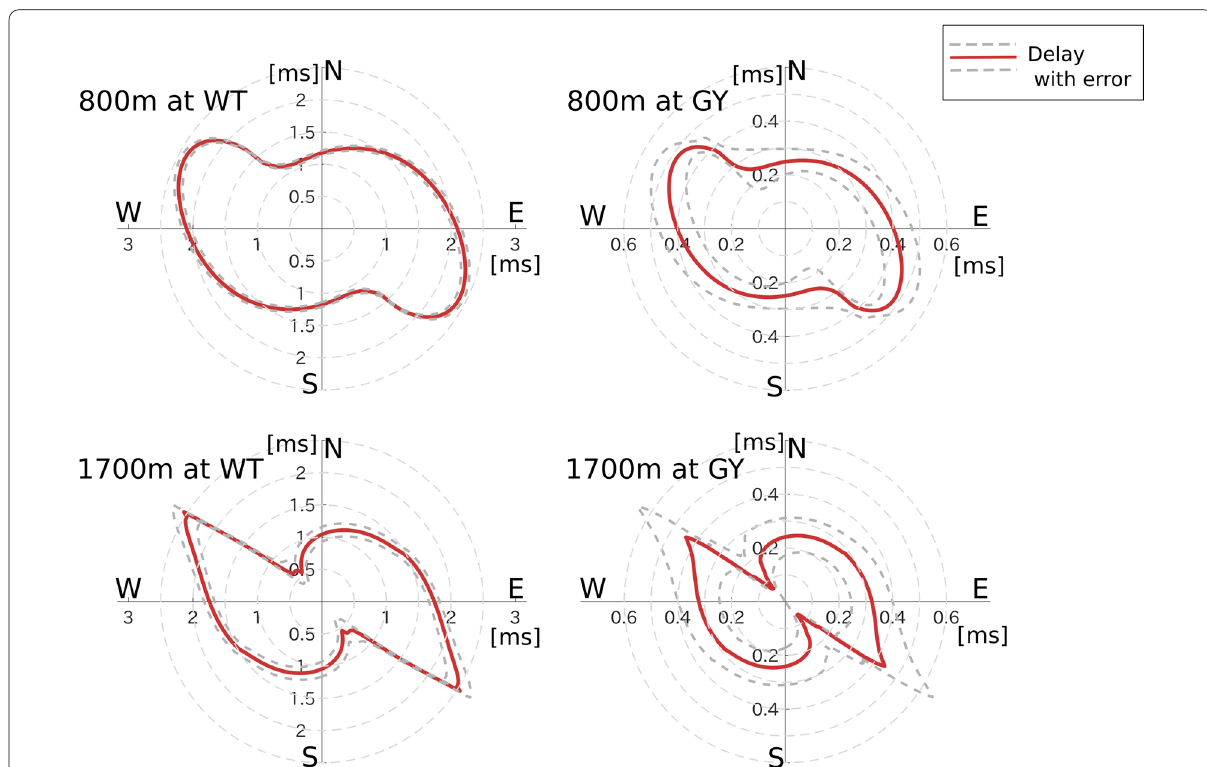
Fig. 9 Azimuthal variation in the coseismic delay in travel time. The red line shows the azimuthal variation in the coseismic delay. The vertical and horizontal axes indicate the NS and EW directions, respectively. Distances from the origin indicate coseismic delay. Gray dashed lines indicate 95% confidence intervals. The top and bottom panels show the results for the 800-m and 1700-m sensors. The left and right panels show the results for the WT and GY earthquakes, respectively